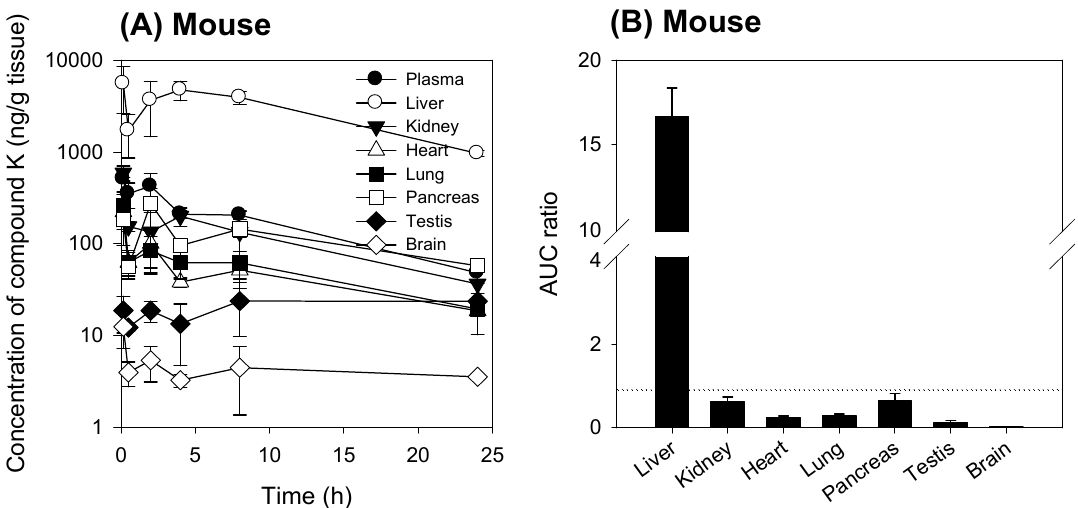
Figure 3. ( A ) Tissue concentration vs. time profile of compound K following intravenous injection of compound K at a single dose of 2 mg/kg in mice. ( B ) AUC ratios of compound K in the liver, kidney, heart, lung, pancreas, testis, and brain to plasma following intravenous injection (2 mg/kg) in mice. AUC was calculated from the data shown in ( A ) and the dotted line in ( B ) represents unity. Data are expressed as mean ± standard deviation from four rats at different time points.